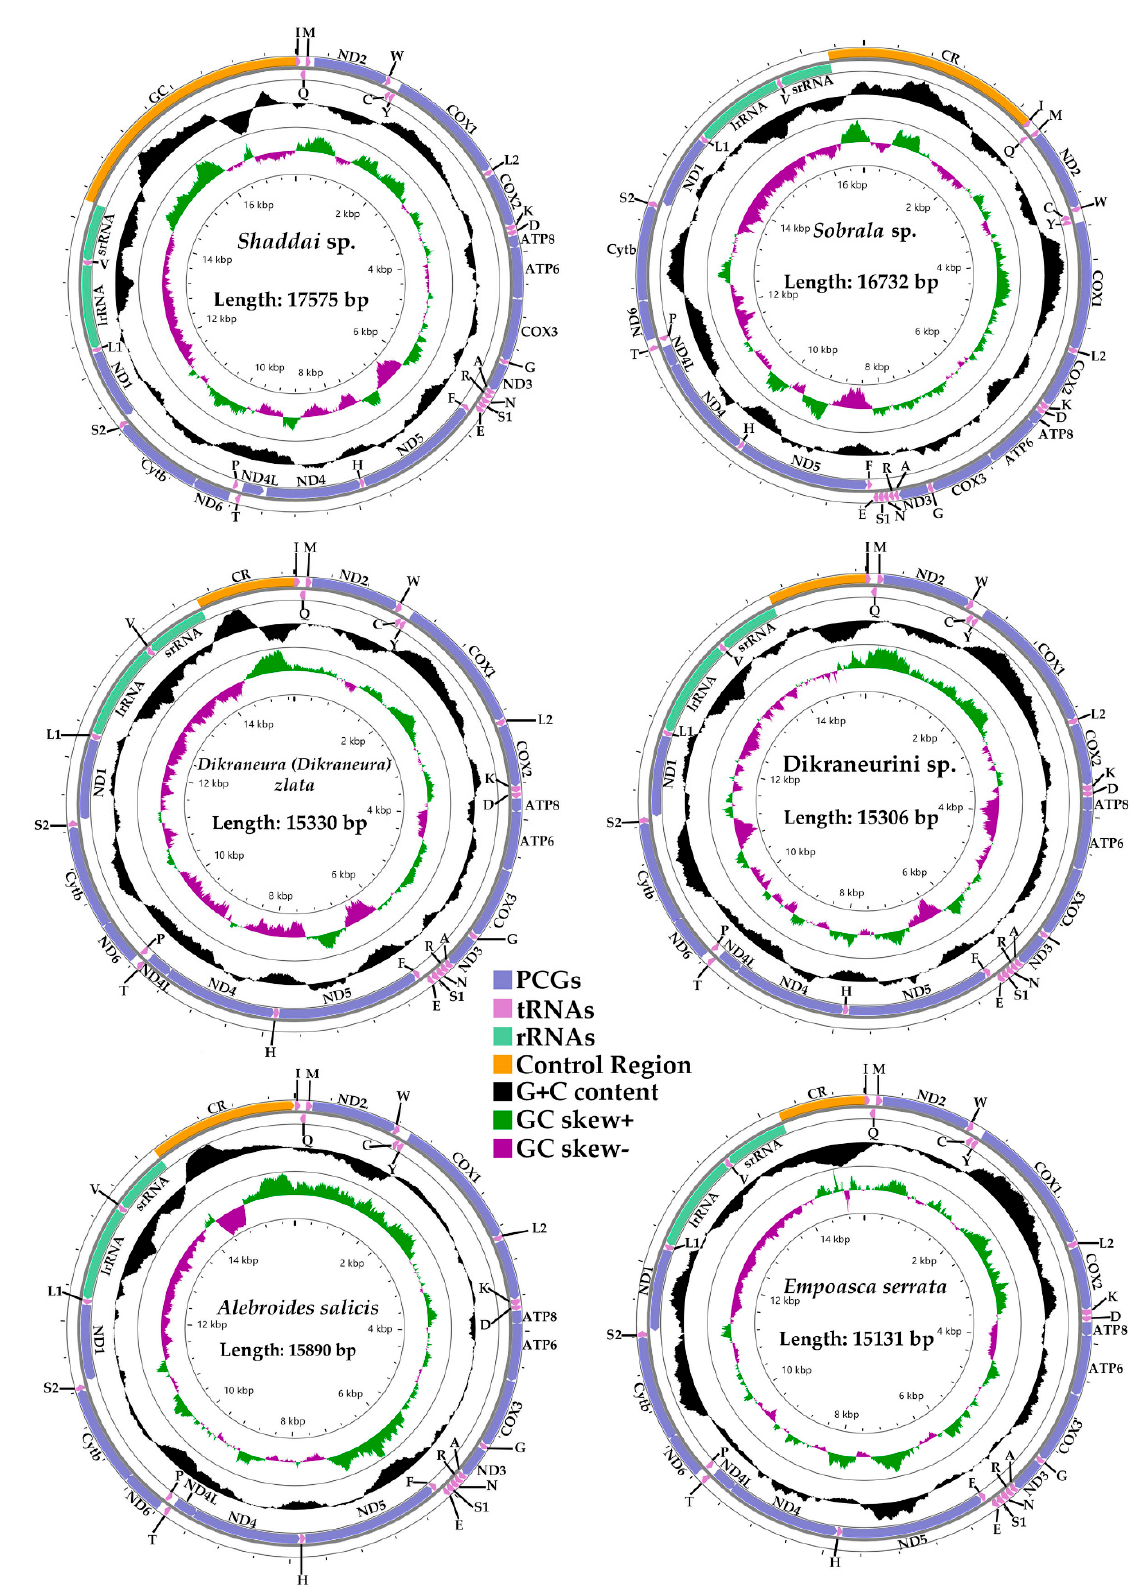
Figure 1. Circular map of the mitochondrial genome of Shaddai sp., Sobrala sp., Dikraneura ( Dikraneura ) zlata , Dikraneurini sp., Alebroides salici and Empoasca serrata .